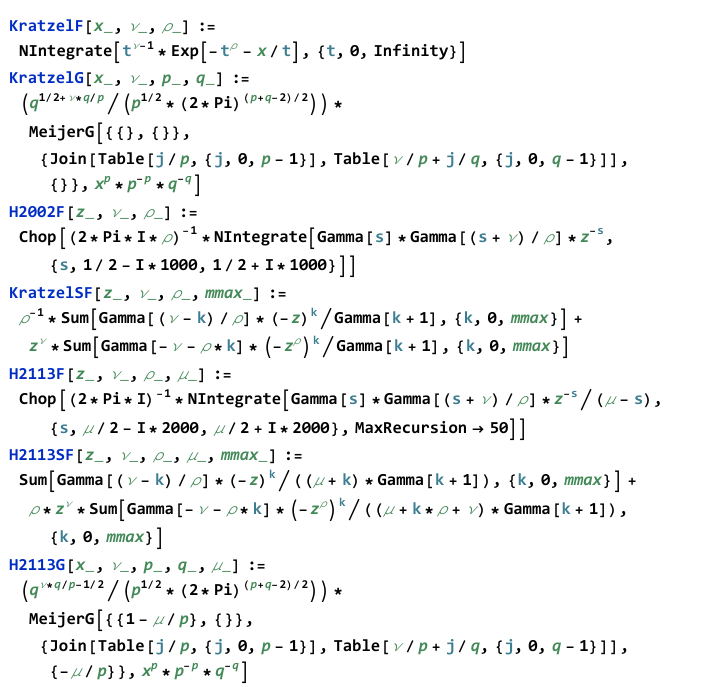
Figure 3. Algorithms used to implement the special functions used in the present